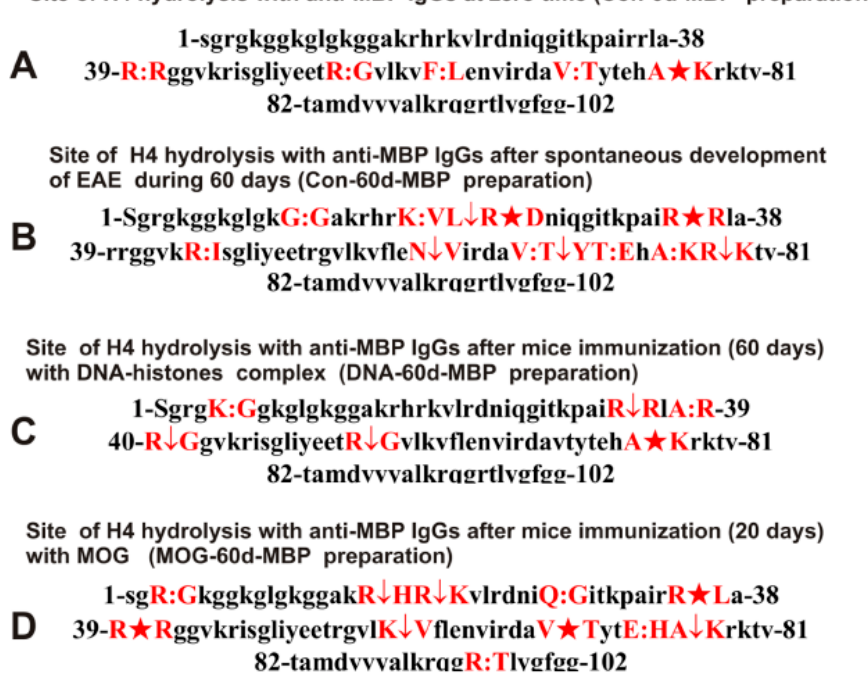
Table 1. Sites of H4 histone hydrolysis by IgGs against five histones and MBP *. Molecular Mass Products of Hydrolysis (Da) and in the Brackets Corresponding to These Pep-